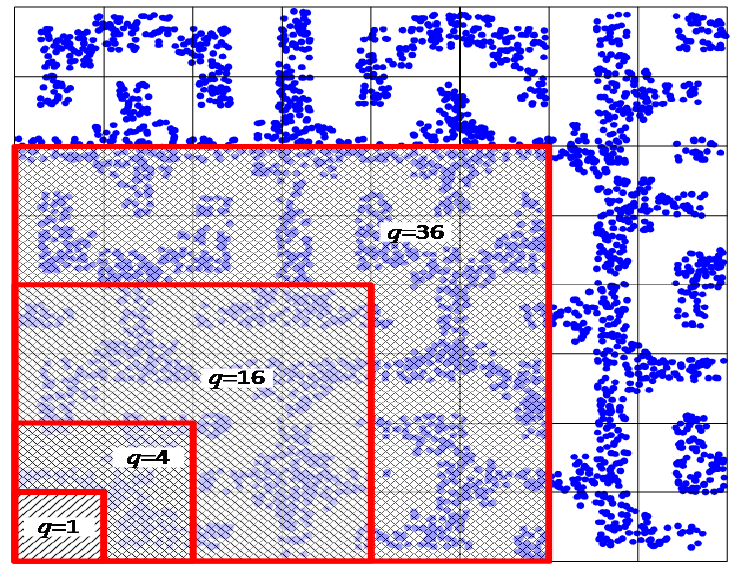
Figure 6. Building aggregated